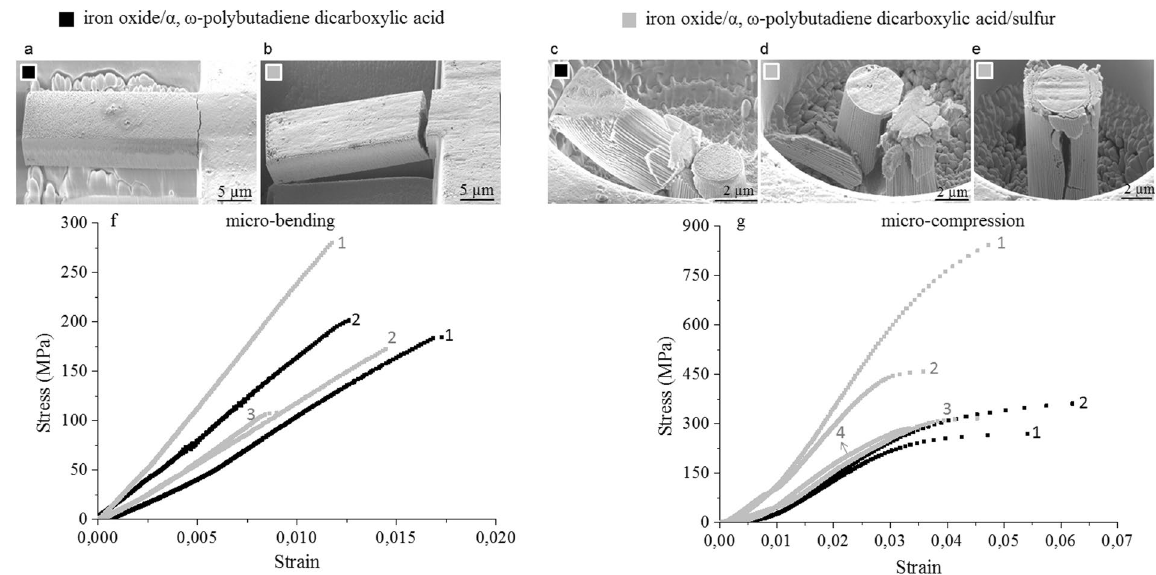
Figure 2. Micromechanical test of the nanocomposites. ( a – e ) Representative failure modes of the nanocomposite iron oxide/ α , ω -polybutadiene dicarboxylic acid (black, a and c ) and iron oxide/ α , ω - polybutadiene dicarboxylic acid/sulfur (grey, ( b , d , e )). Stress-strain curves obtained under micro-bending ( f ) and micro-compression ( g ) are plotted. Specimen legends 1–4 are given in Tables S2 and S3 in supplementary